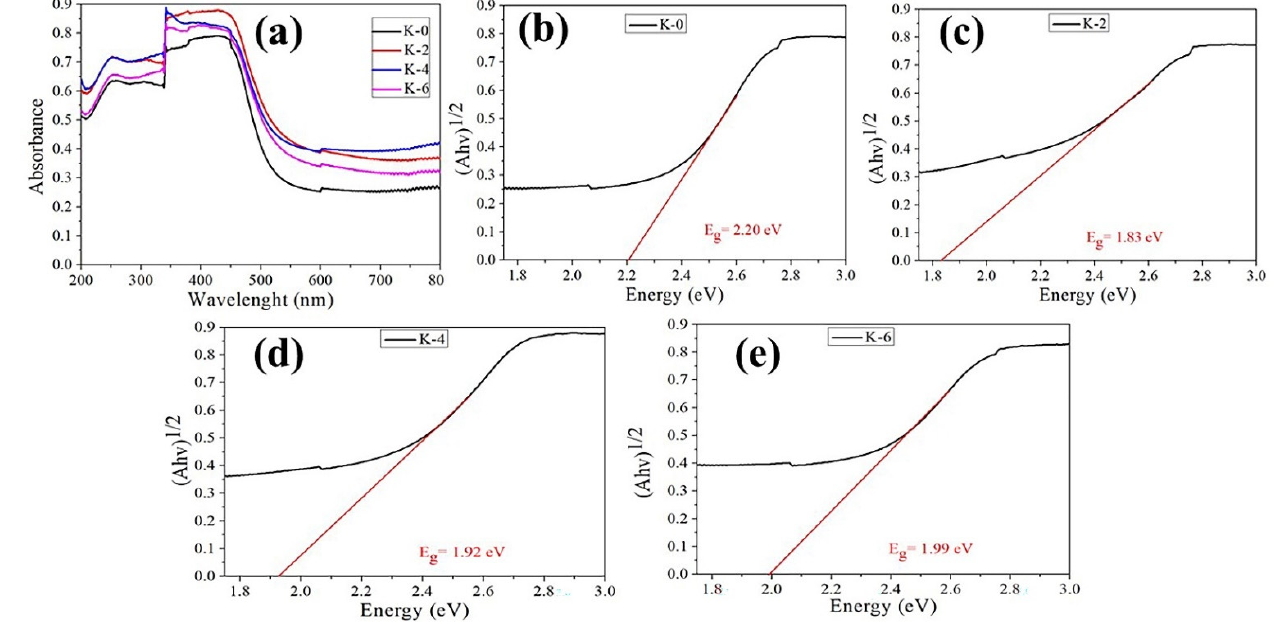
Figure 6. ( a ) Cs ₃ Bi ₂ I ₉ perovskite film-absorption spectrum K-0 to K-10. ( b – e ) Tauc plots of the calcu- Figure 6. ( a ) Cs 3 Bi 2 I 9 perovskite film-absorption spectrum K-0 to K-10. ( b – e ) Tauc plots of the lated optical-absorbance bandgaps of perovskite films K-0, K-2, K-4, and K-6. calculated optical-absorbance bandgaps of perovskite films K-0, K-2, K-4, and